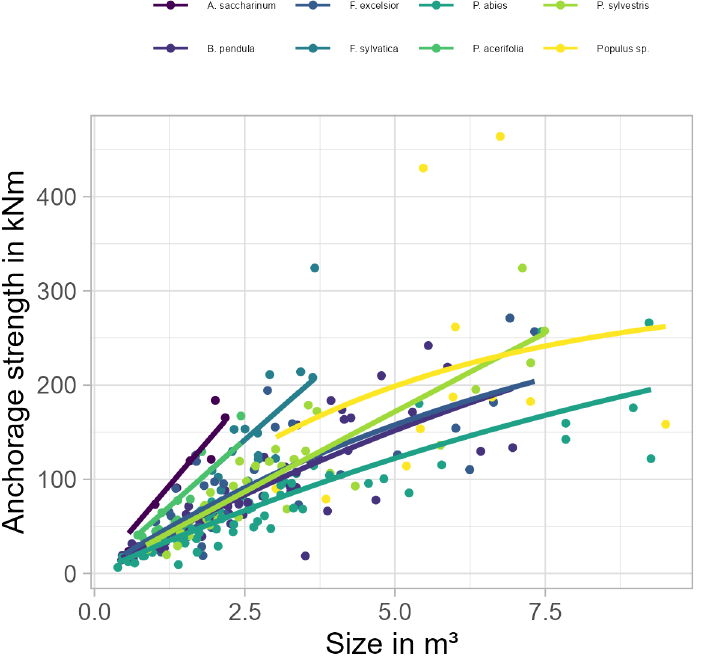
Figure 1. Species effect on anchoring strength (fitted lines: M a = y 0 ( 1 − e − a Size ) , ANOVA: Table